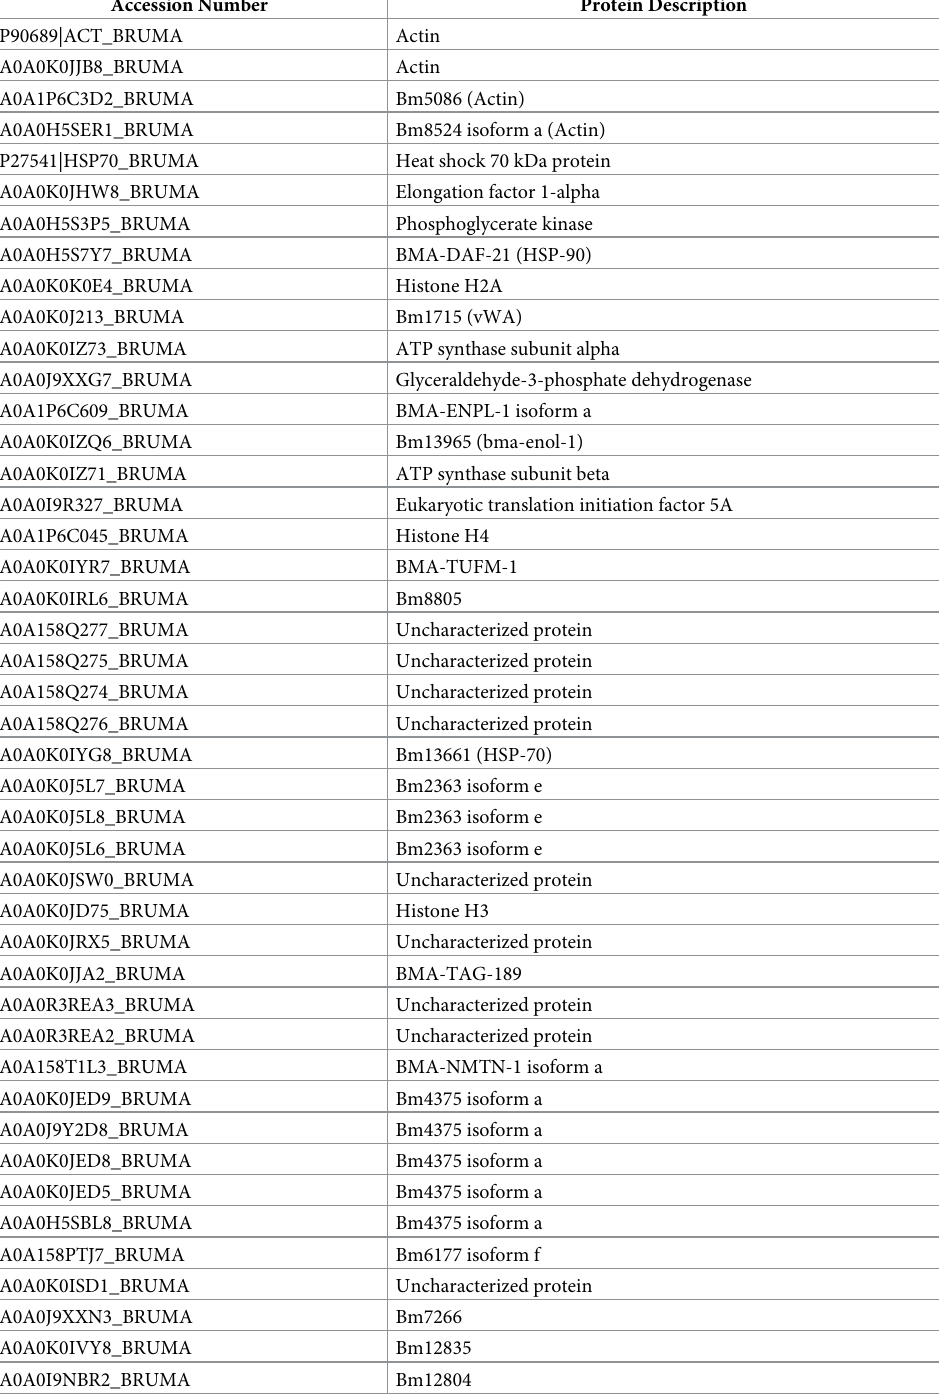
Table 1. Proteins present in all EV preparations